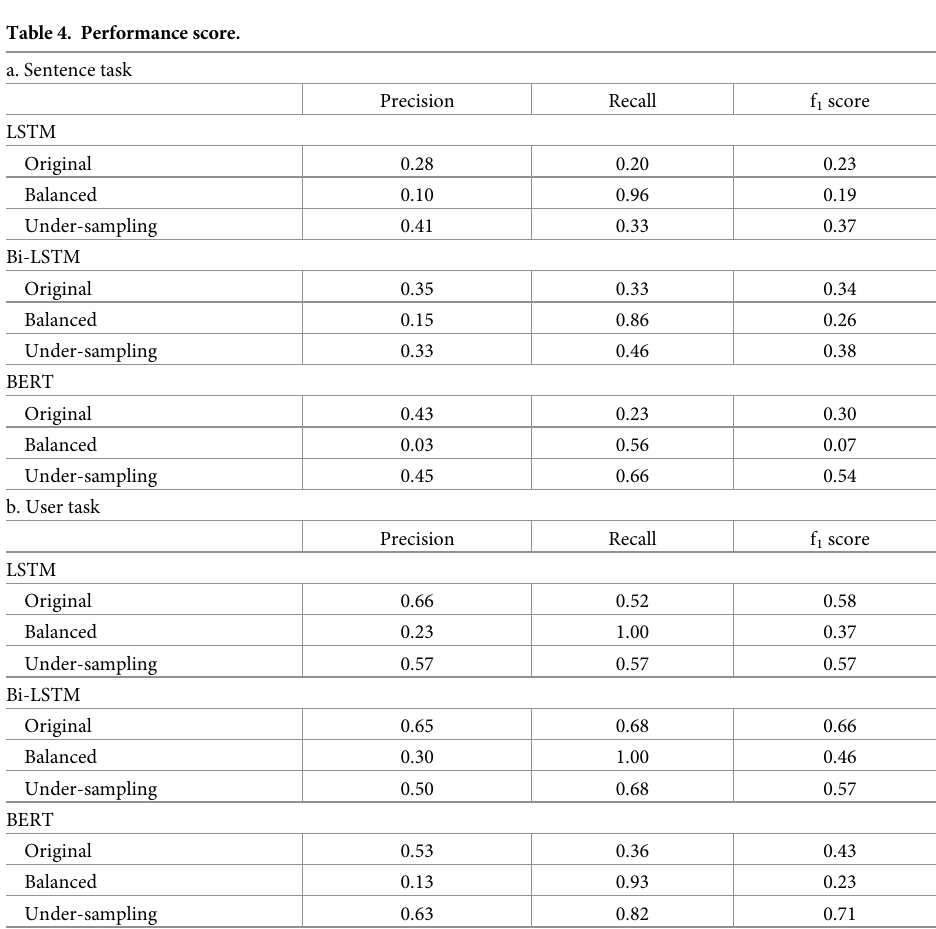
Table 4. Performance